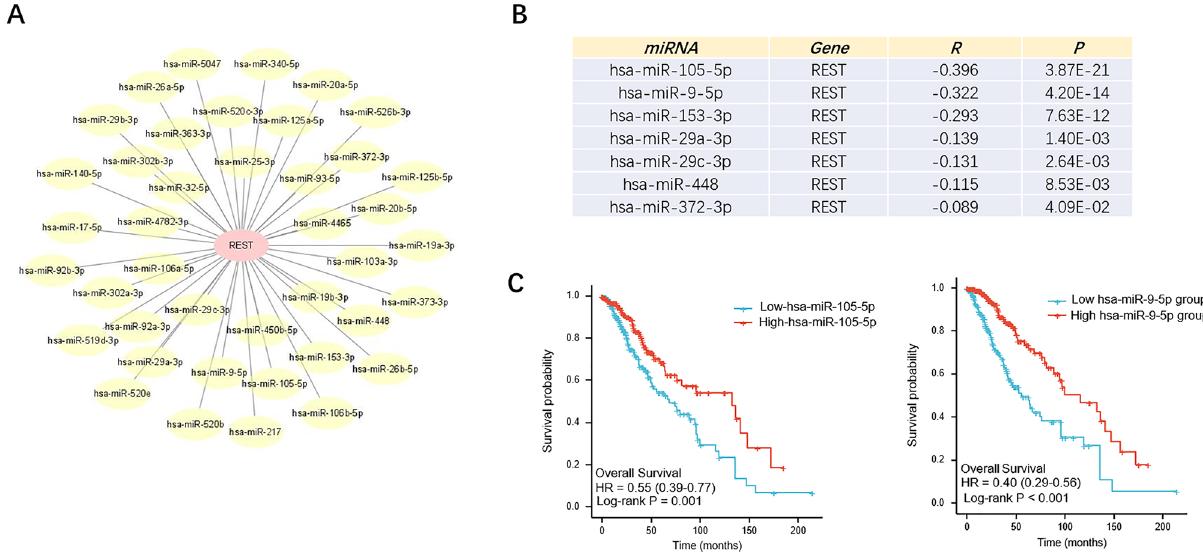
Figure 3. Identification of potential upstream miRNAs of REST in glioma. ( A ) The miRNA-REST regulatory network established by cytoscape 3.8.0 software (https:// cytos cape. org/). ( B ) The expression correlation of predicted miRNAs and REST in glioma assessed by StarBase (http:// starb ase. sysu. edu. cn/). ( C ) The Kaplan– Meier curves of predicted miRNAs in glioma in TCGA cohort by GraphPad Prism 9.3.1 (https:// www. graph pad. com/). log-rank test P value <